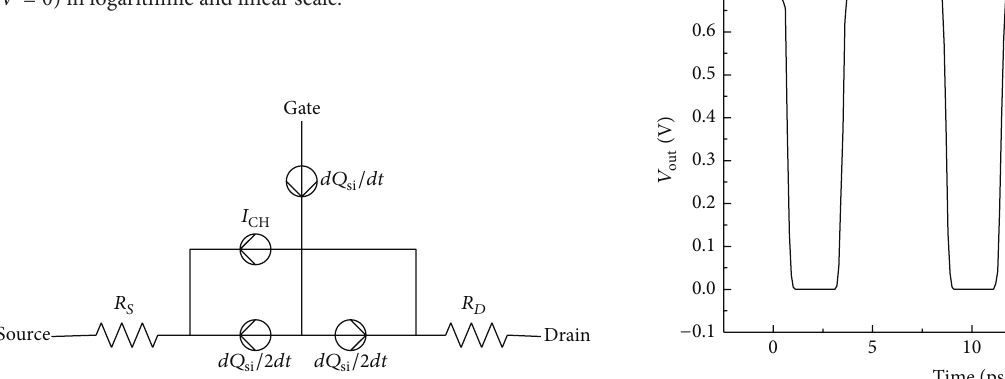
Figure 4: Channel charge density (per unit area) at the source end ( 𝑉 = 0 ) in logarithmic and linear scale.